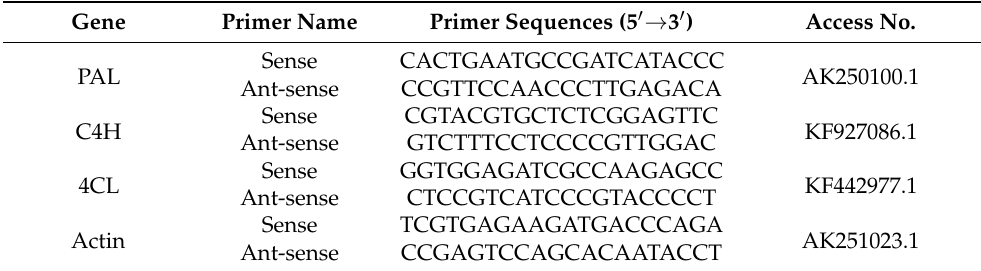
Table 1. Primers used in this